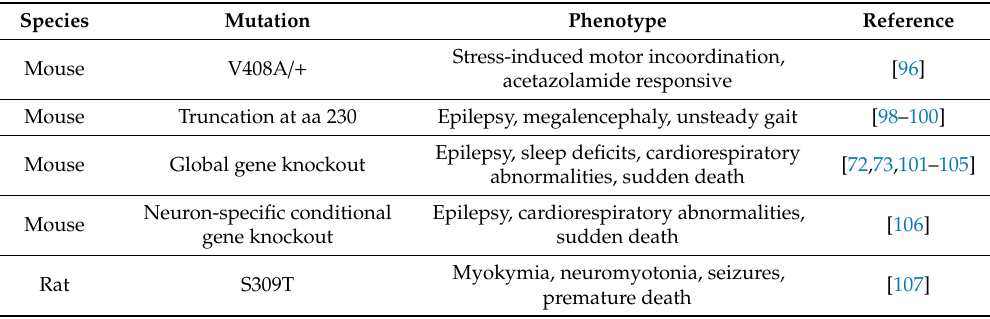
Table 2. Rodent models of Kcna1 mutations and their associated